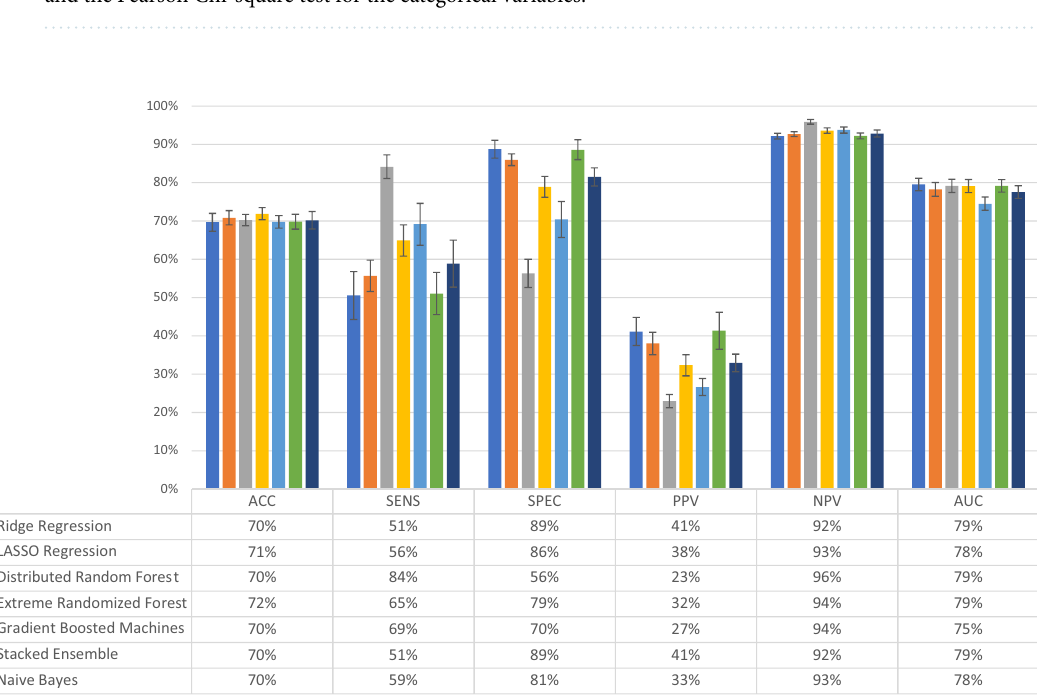
Table 1. Characteristics of the study participants by depression status at 6 weeks postpartum (EPDS a score 0–11 vs. 12–30) ( n = 4313). Bold values indicate p < 0.05. a Edinburgh Postnatal Depression Scale. b Interquartile range. c Self-reported and/or diagnosed by psychiatrist. d Pregnancy week 17, self-reported. e EPDS ≥ 12 at pregnancy week 17 or 32 or at delivery. f Selective serotonin reuptake inhibitors. g Based on either the Beck Anxiety Inventory, the State Trait Anxiety Inventory (STAI) or the anxiety subscale of the EPDS (EPDS 3A, items 3–5). h EPDS ≥ 12 at pregnancy week 17, 32 or 38. i Pregnancy week 32. j Self-reported, pregnancy week 32. k Attachment Style Questionnaire. l Sense of Coherence Questionnaire-29. m Lifetime Instances of Traumatic Events. n Swedish Universities scales of Personality. o Based on the Mann–Whitney test for continuous variables and the Pearson Chi-square test for the categorical variables.